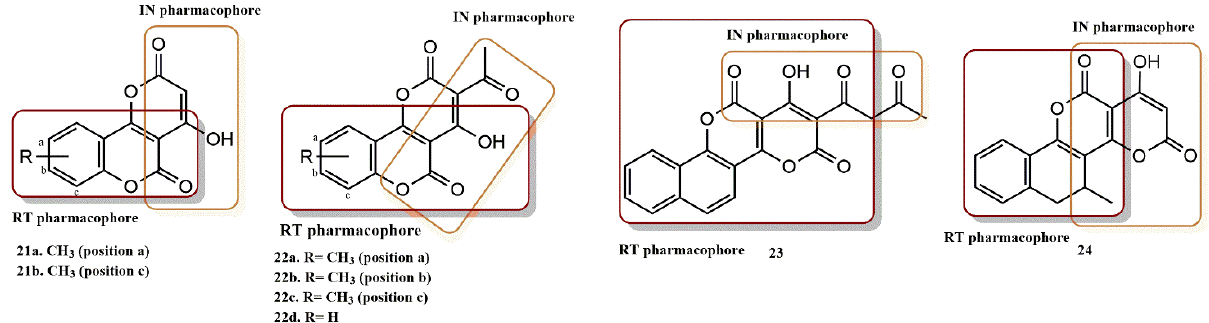
Figure 20. RT and IN pharmacophores of new active synthesized compounds 21a-b , 22a-d , 23 and 24 .